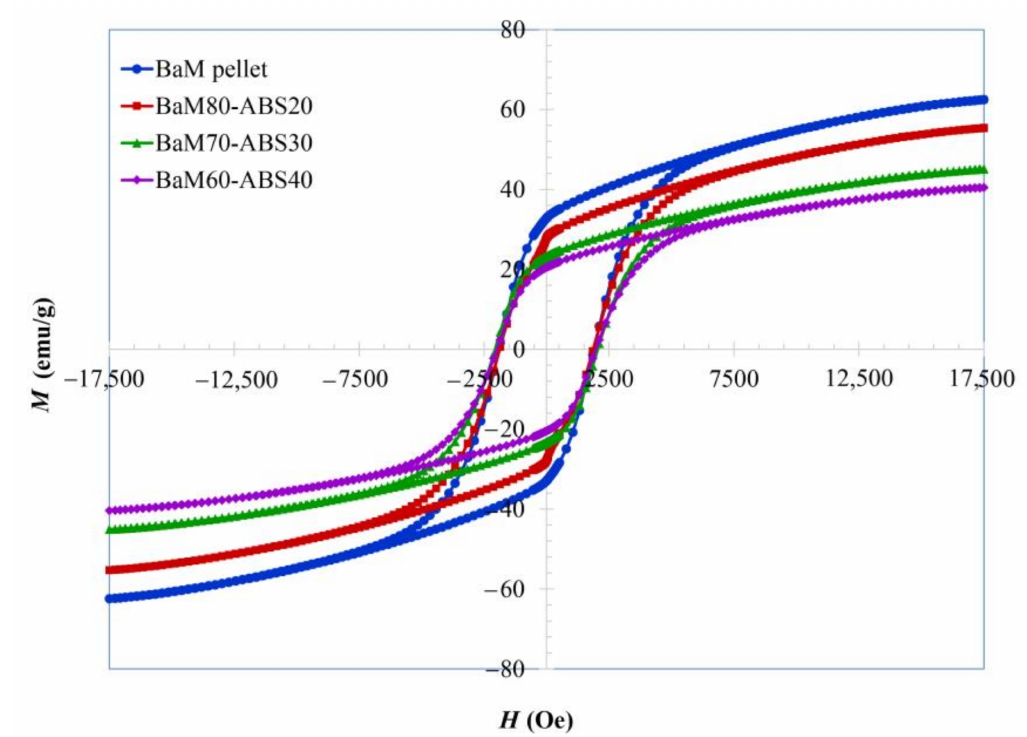
Figure 5. Hysteresis loops of BaM-ABS composites with varying ferrite loading of 60%, 70%, and 80%, as well as a pressed BaM